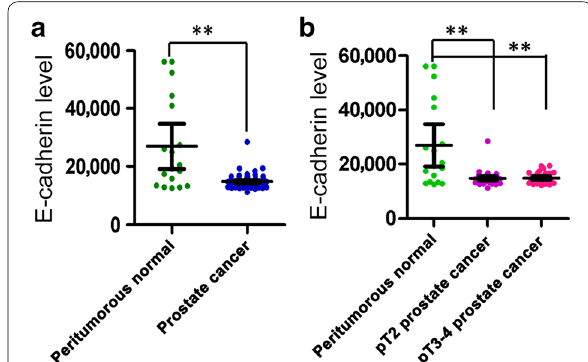
Fig. 7 E-cadherin mRNA expression level decreases in PCa tumors in the meta-analysis of the ONCOMINE database. a E-cadherin mRNA expression level is lower in PCa tissues than in peritumorous normal prostate tissues. b E-cadherin mRNA expression is significantly lower in pT2 and pT3-4 PCa tumors than in peritumorous normal prostate tissues. The P value was calculated by Student’s t test, ** P < 0.01, * P <